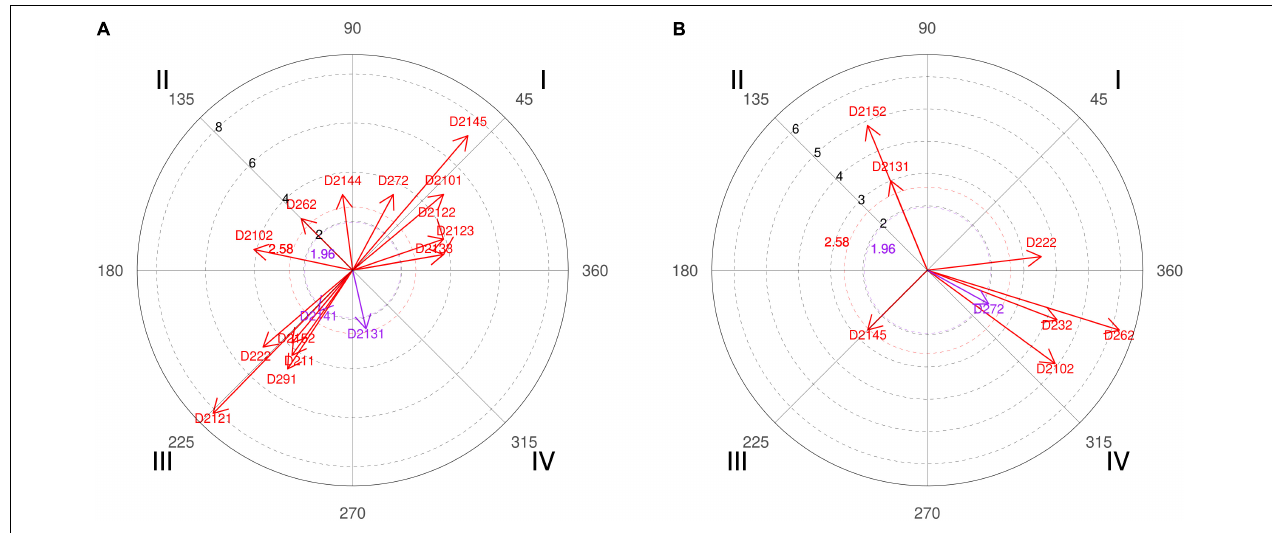
FIGURE 9 | (A,B) Relationship of conditioned behaviors that present a significant relationship with the focal behaviors “favorable evaluation” and “unfavorable evaluation” analyzing question 14 of the in-depth interviews. In “favorable evaluation,” a total of 16 significant vectors were detected, and in “unfavorable evaluation,” a total of eight significant vectors were